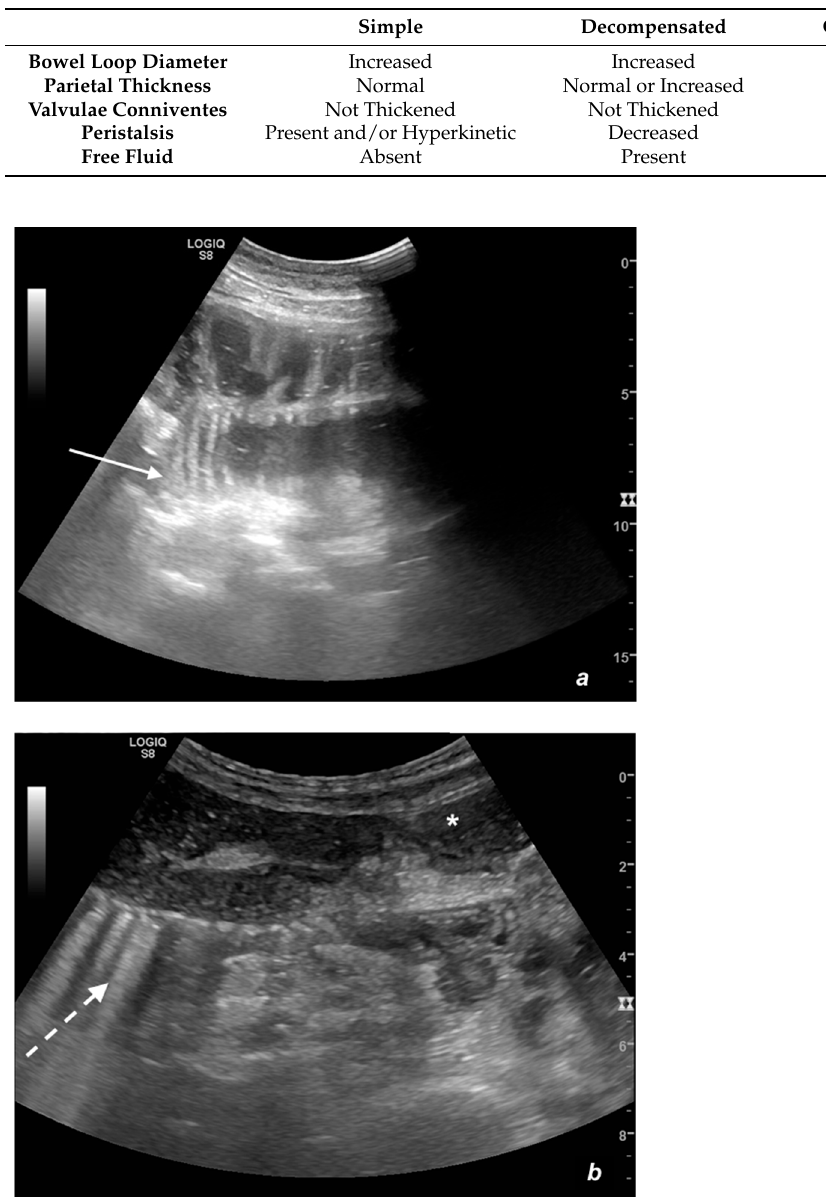
Table 1. Ultrasound criteria for small bowel obstruction (SBO) diagnosis.